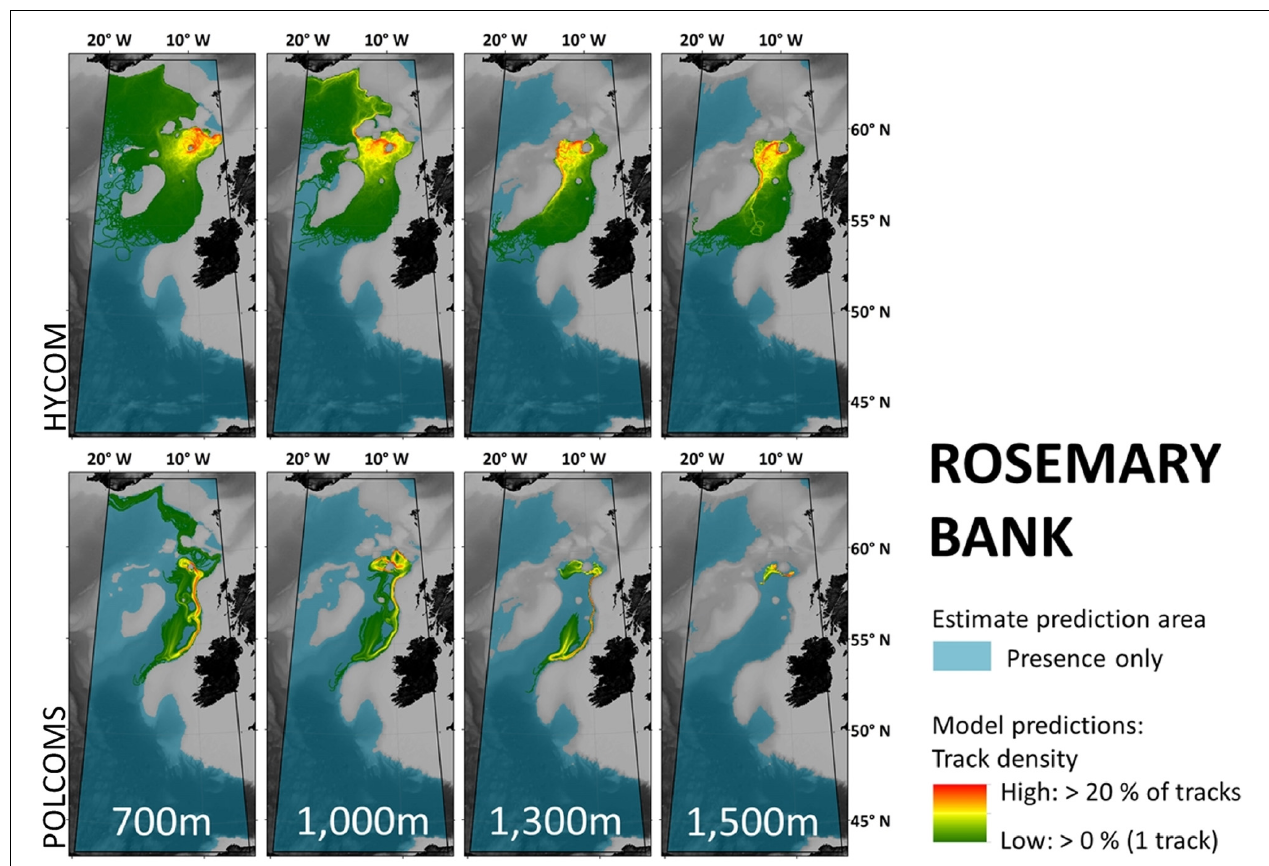
FIGURE 3 | Maps per depth band of predicted larval dispersal as simulated from Rosemary Bank. Simulations from HYCOM and POLCOMS models are displayed as track densities delineating between occasional and persistent pathways of dispersal. All estimate prediction areas fill the POLCOMS domain but differ between maps due to the 2D nature of simulations excluding areas of raised topography. Spatial correlations were conducted comparing the extent of modeled and estimated predictions and the extent and density information of each modeled prediction ( Table 2 ). [All maps were created in ArcGIS 10.3 (http://www.esri.com) with GEBCO 30 arc-second topography, available from www.gebco.net, and projected using Albers Equal Area Conic with modified standard parallels and meridian (sp 1 = 46 ◦ N, sp 2 = 61 ◦ N, m = 13 ◦